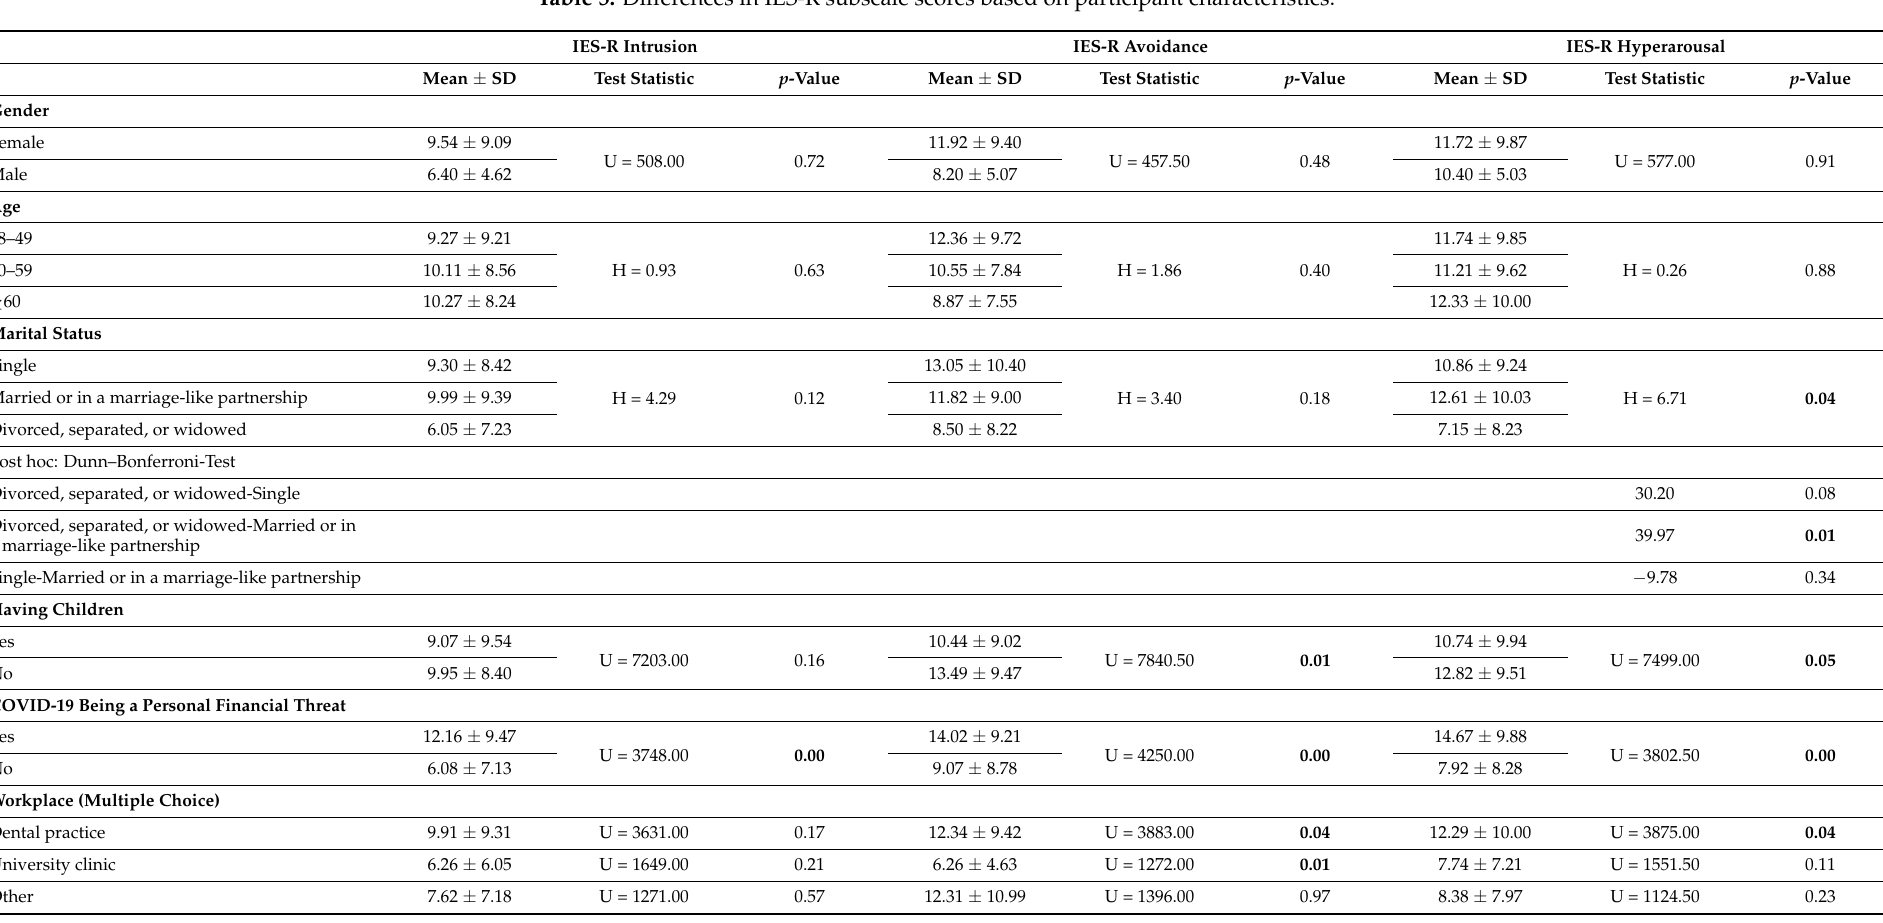
Table 5. Differences in IES-R subscale scores based on participant